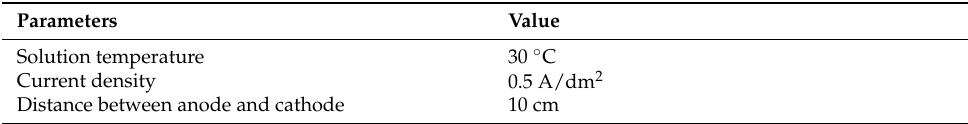
Table 5. The selected parameter combination for copper